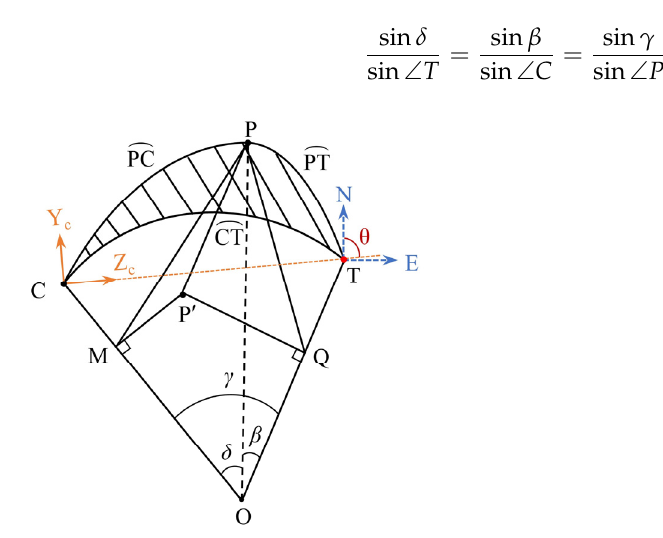
Figure 5. Spatial geometry for the camera C and the target T.